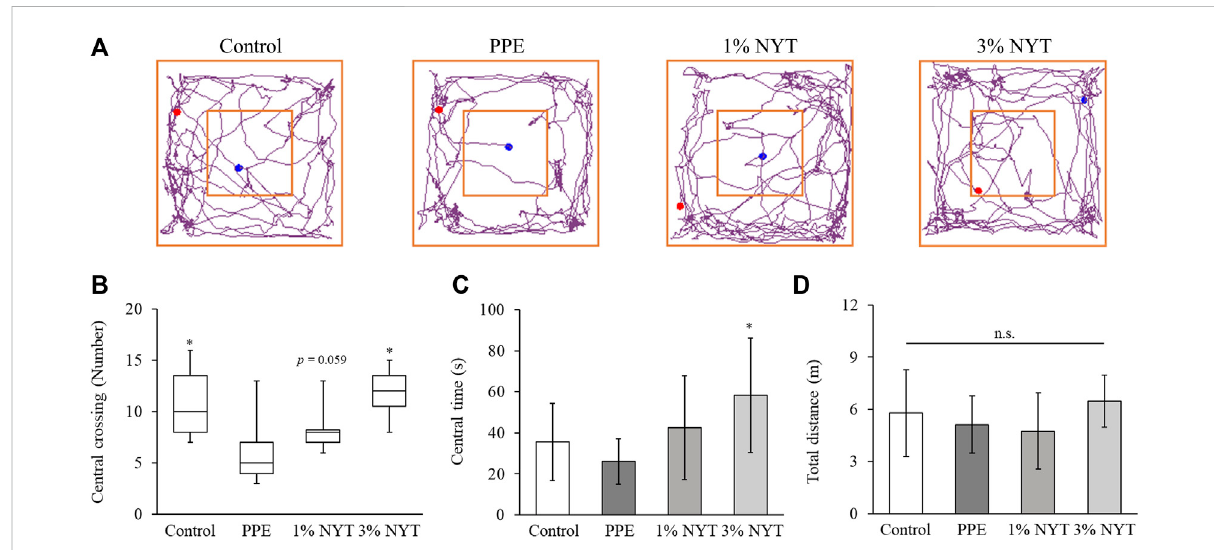
FIGURE 5 Effect of ninjin ’ yoeito on PPE-induced anxiety-like behaviors. (A) Tracing pathway, (B) Crossing number, (C) Time spent in the central zoneand (D) Total distance in the open fi eld. (Control n = 10, PPE n = 11, 1% NYT n = 8, 3% NYT n = 7). Values are expressed as median [25% tile, 75% tile] or means ± S.D. p p < 0.05 vs. PPE group by Steel or Tukey test.